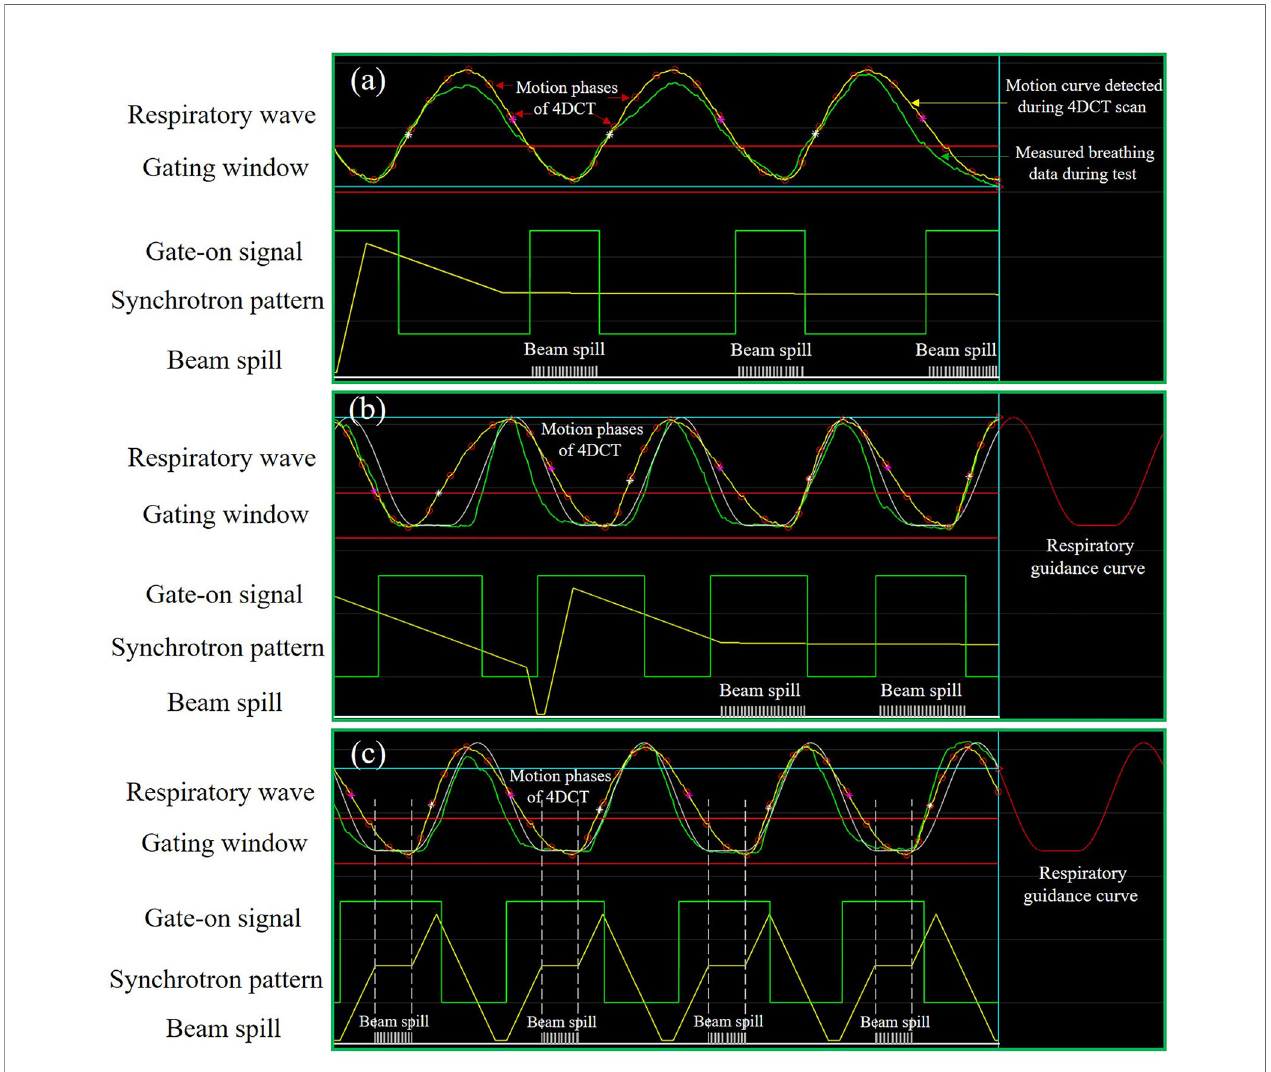
FIGURE 1 | Schematic diagram of the synchrotron operation modes and motion mitigation methods. (A) Free breathing-based gated phase-controlled rescanning (PCR) method delivered under the extended fl attop synchrotron operation. (B) Breathing guidance-based gated PCR method delivered under the extended fl attop synchrotron operation. (C) Breathing guidance method delivered under the fi xed fl attop synchrotron